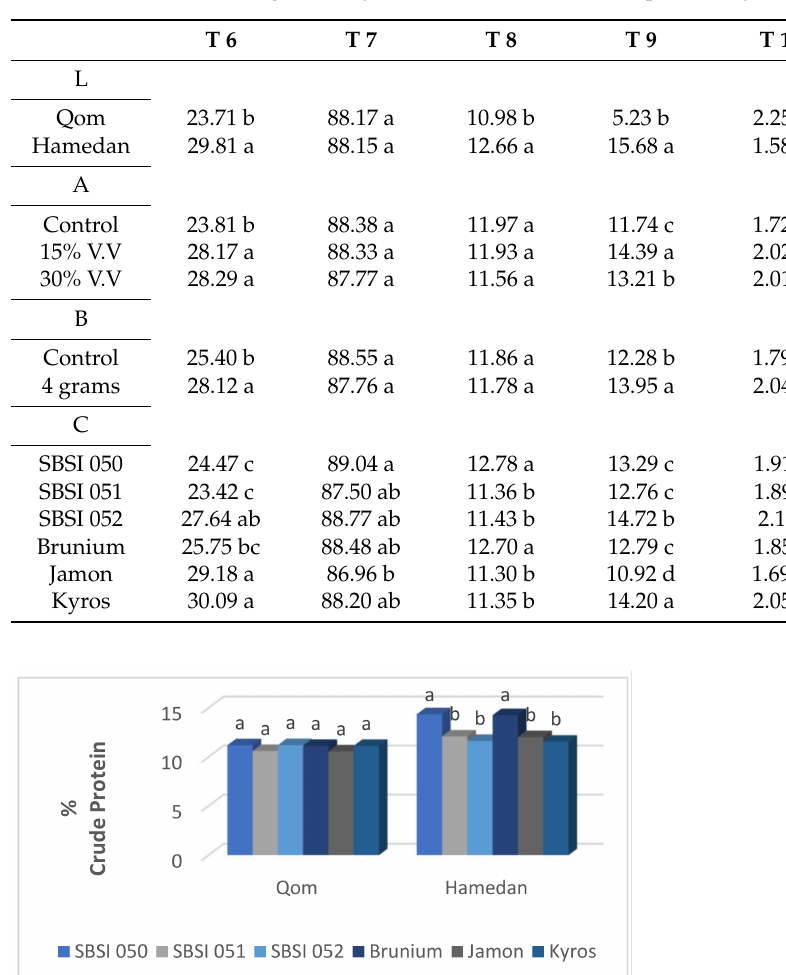
Table 5. Mean comparison of evaluated quantitative and qualitative traits. T 6: Root length (cm); T 7: Root dry matter digestibility (%); T 8: Root crude protein (%); T 9: Sodium content